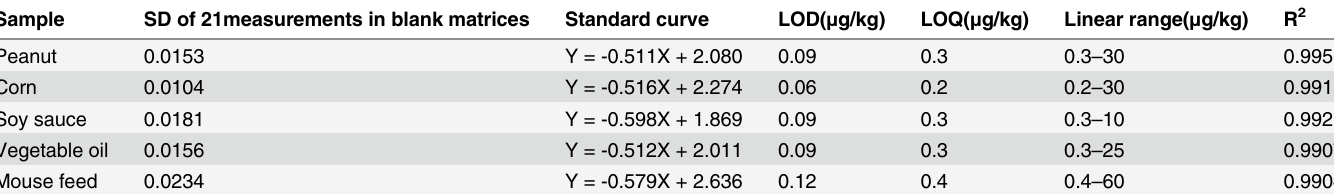
Table 1. CTRFIA determination in peanuts, corn, soy sauce, vegetable oil, and mouse